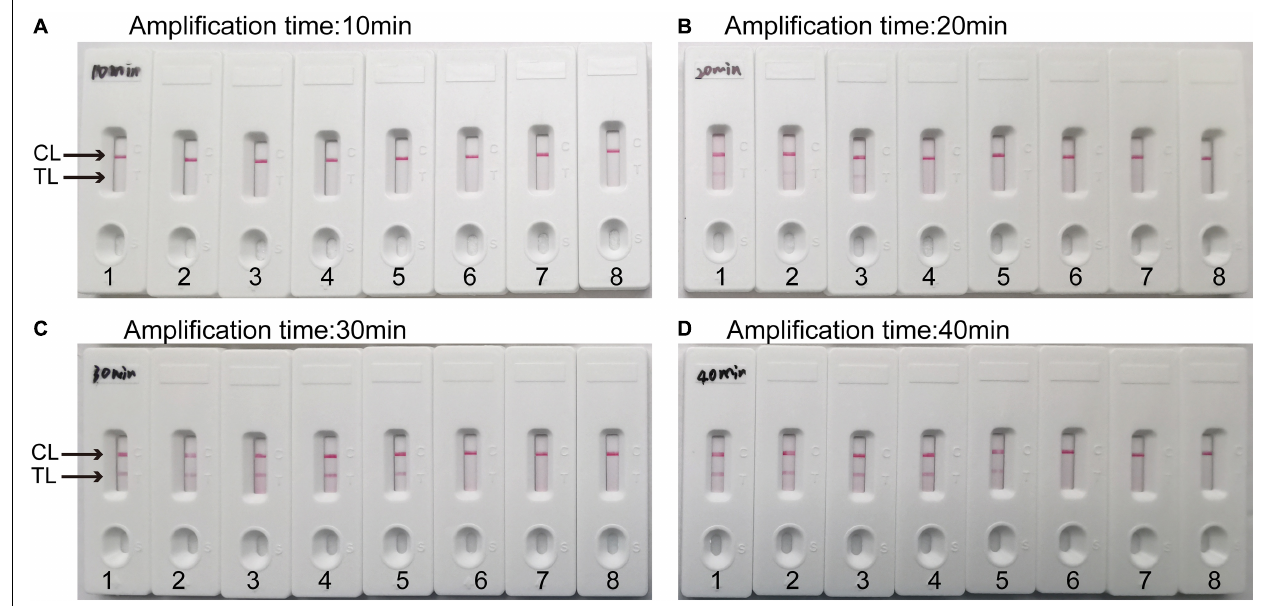
FIGURE 5 | Optimal detection time required for C. tropicalis MCDA-LFB assay. Four different reaction times ( (A) 10 min; (B) 20 min; (C) 30 min; (D) 40 min) were evaluated at 64 ◦ C. Biosensors 1–7 represent C. tropicalis ATCC13803 DNA levels of 10 ng, 10 pg, 1 pg, 100 fg, 10 fg, 1 fg, and 100 ag per reaction, respectively; 8 represents a blank control (DW). The best amplification time was observed when MCDA lasted for 30 min (C) .